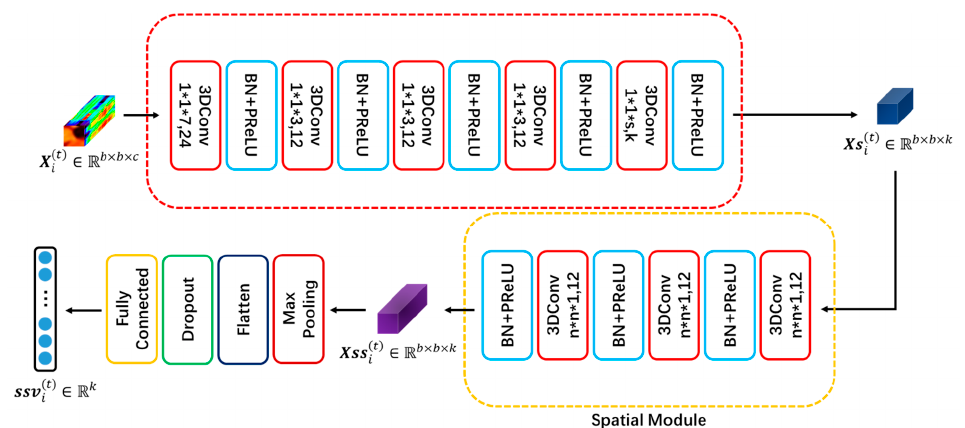
Figure 1. Network for extracting spectral-spatial features of hyperspectral tensors.